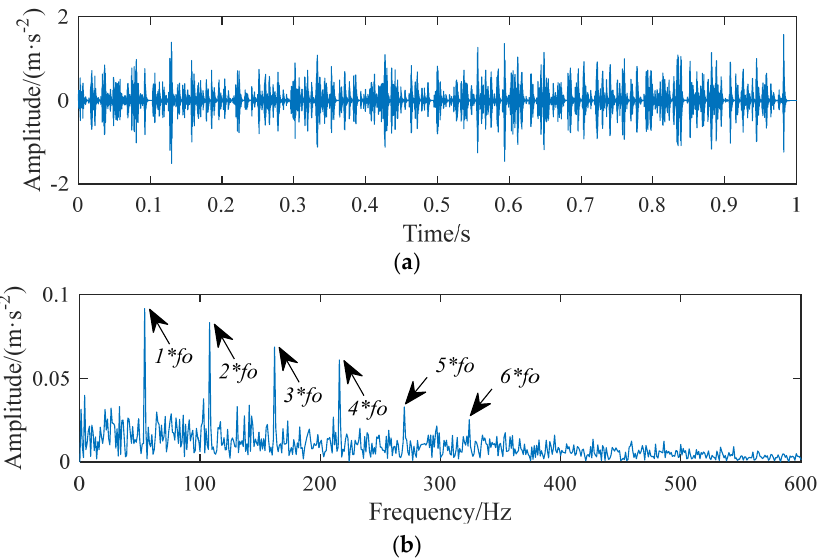
Figure 9. The result of SNR = − 17 dB simulation signal processing based on the LWFSS-AEWT algorithm: ( a ) Time domain waveform of reconstructed signal; and ( b ) Envelope spectrum of the reconstructed signal.